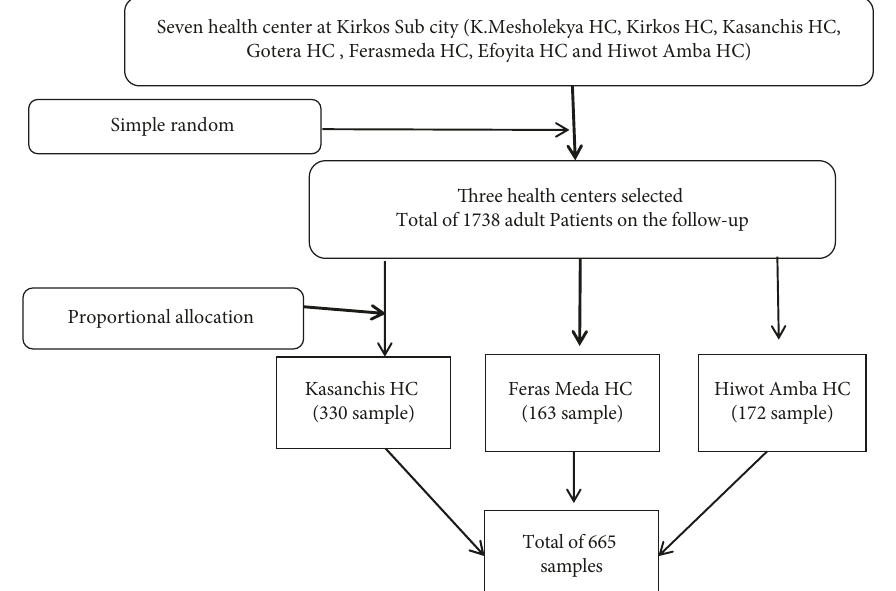
Figure 1: A schematic sampling procedure to study mortality and its predictors in adult human immune-deficiency virus-infected patients attending their antiretroviral treatment at health centers, Kirkos subcity, Addis Ababa, Ethiopia,